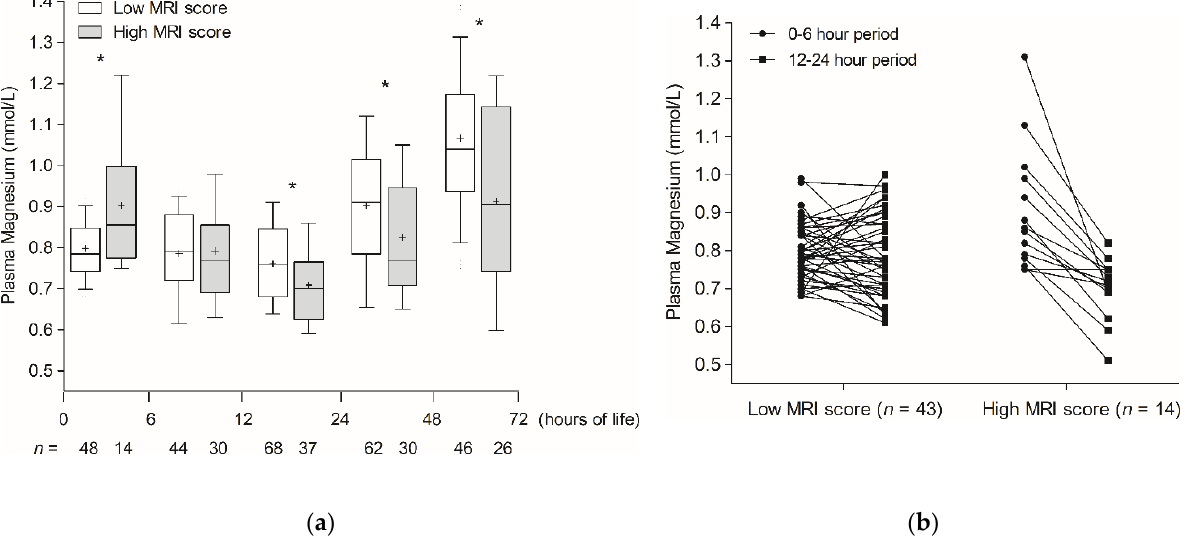
Figure 2. Plasma magnesium kinetics over the first 72 h of life in infants with neonatal encephalopathy according to the MRI score. ( a ) Graphic representation of plasma magnesium values (in mmol/L) according to five time periods, (i.e., from birth to the sixth hour of life, from the sixth to the 12th hour of life, from the 12th to the 24th hour of life, from the 24th to the 48th hour of life and from the 48th to the 72nd hour of life). White box-and-whiskers plots represent infants with low MRI score. Grey box-and-whiskers plots represent infants with high MRI score. Crosses in box-and-whiskers plots correspond to the means. Statistical analysis: t -test for independent samples, * p < 0.05 compared with plasma magnesium values of infants with low MRI score in the same time period. ( b ) Evolution of plasma magnesium values from the initial period, i.e., before the sixth hour of life (black circles) to the 12 – 24 h period (black squares) according to the MRI score.